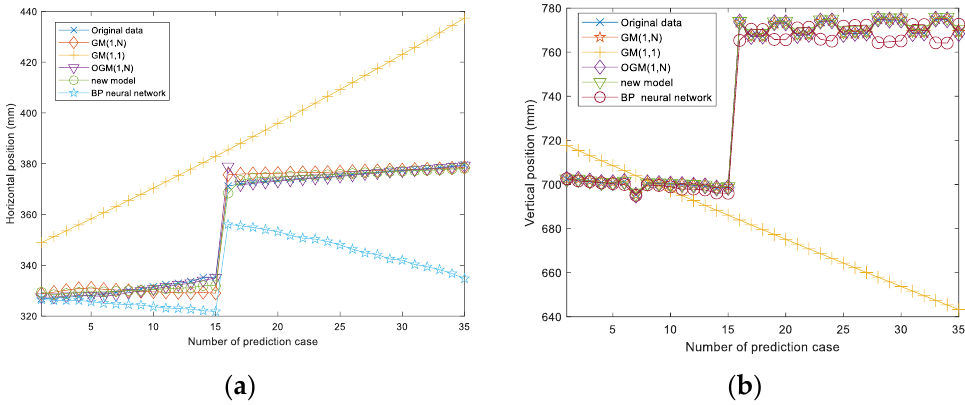
Figure 15. Curve of prediction for sensing unit 2. ( a ) Graph of horizontal displacement prediction effect of sensing unit 2. ( b ) Graph of vertical displacement prediction effect of sensing unit 2.